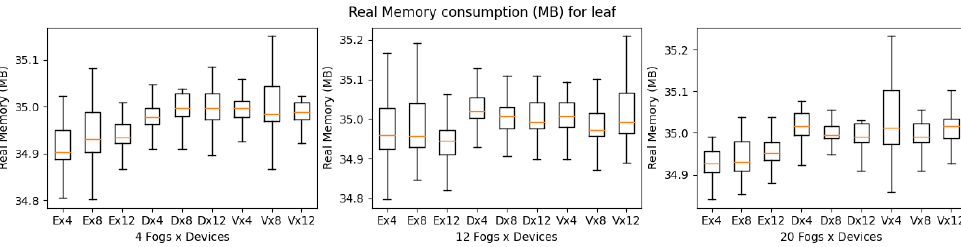
Figure 15. Real memory consumption for LEAF during simulation (E: eHealth; D: DCNS; V: VRGame).